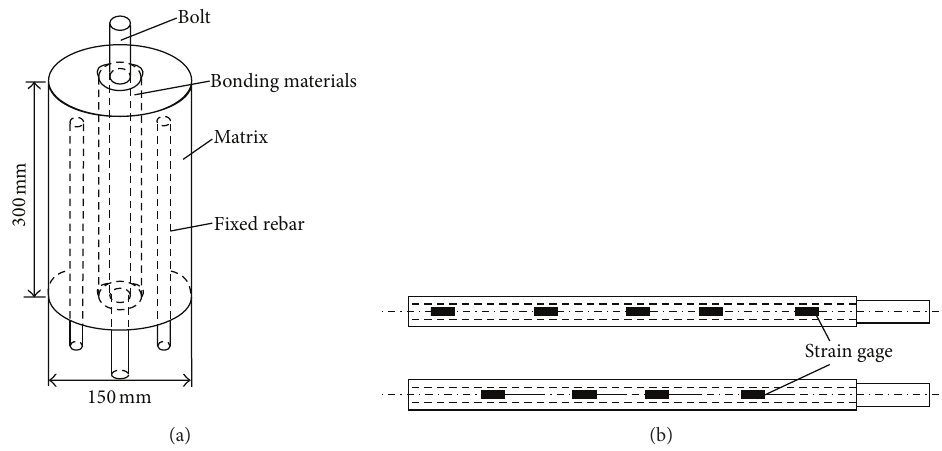
Figure 4: Structure model of anchorage body. (a) Integral structure. (b) Force anchor.